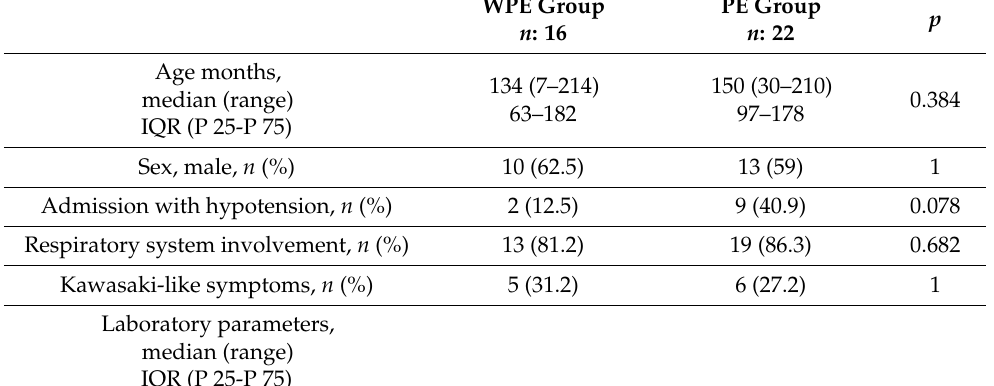
Table 1. Comparison of the characteristics, clinical and laboratory findings of the WPE group and